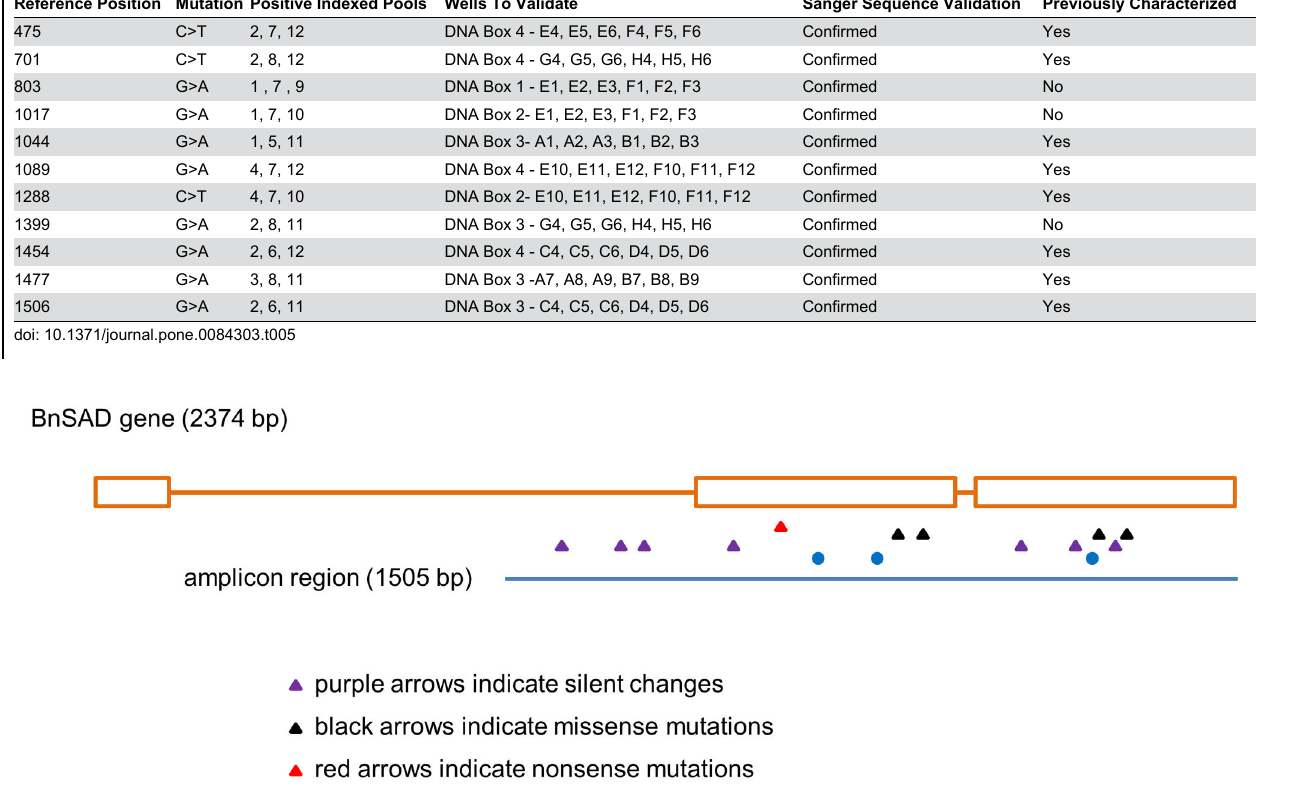
Reference Position Mutation Positive Indexed Pools Wells To Validate Sanger Sequence Validation Previously Characterized